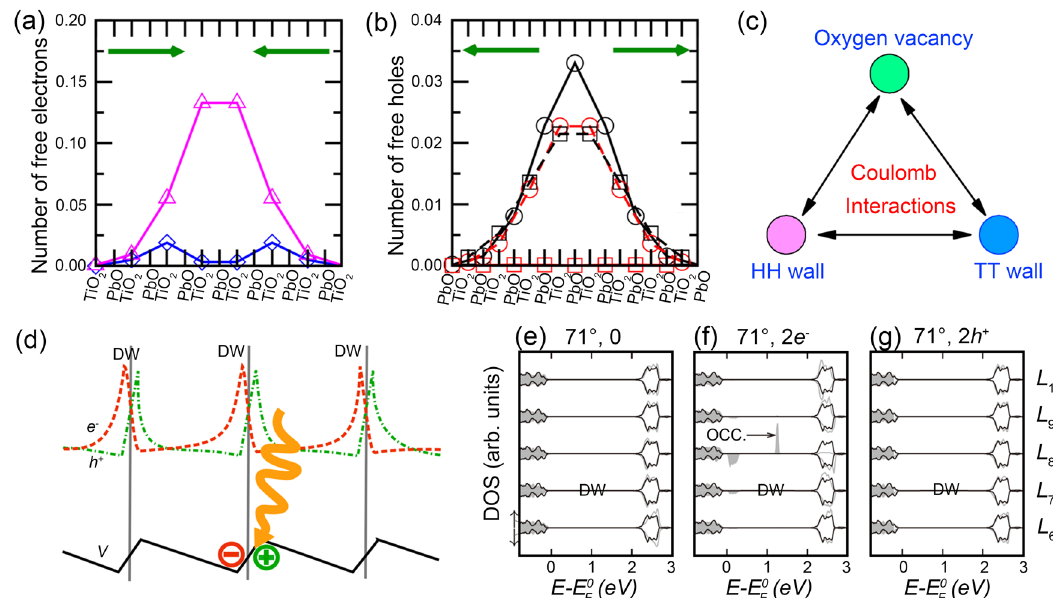
Fig. 7 Conductance of DWs. a , b Free-carrier densities in PbTiO 3 for the domain wall in the ( a ) H – H structure and ( b ) T – T structure. Reproduced with permission from ref. 136 . Copyright [2020] {American Physical Society}. c A schematic representation of the interaction triangle between oxygen vacancy, HH (head-to-head) wall, TT (tail-to-tail) wall. Reproduced with permission from ref. 137 . Copyright [2018] {Elsevier}. d Model for the charge-carrier distribution of excess electrons (e − ), holes (h + ), and the electronic potential (V), at DWs. e – g The density of states (DOS) of the 71° DW system (gray) and the charge-neutral monodomain system (black) projected on the atomic layers. e Charge-neutral DW. f DW with electrons. g DW with holes. d – g From Sabine Körbel et al. Panels d , g are reproduced with permission from ref. 115 . Copyright [2018] {American Physical